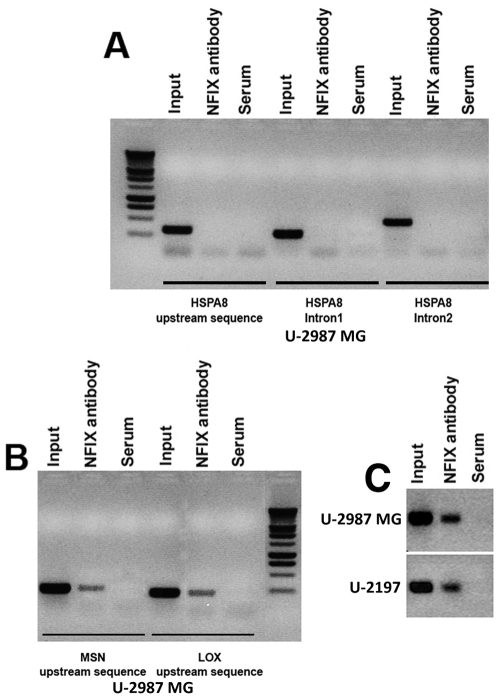
NFIX-DNA interactions at specific loci containing NFI-binding sites.NFIX does not bind to full NFI-binding sites in HSPA8 promoter or in the introns of HSPA8, which contain potential half NFI-binding sites (A). NFIX does bind to identical full NFI-binding sites in MSN and LOX promoters (primers flank the predicted NFI-binding site; refer to Table S2) (B). NFIX is recruited to the HSF1 promoter region devoid of any full NFI-binding sites (C).